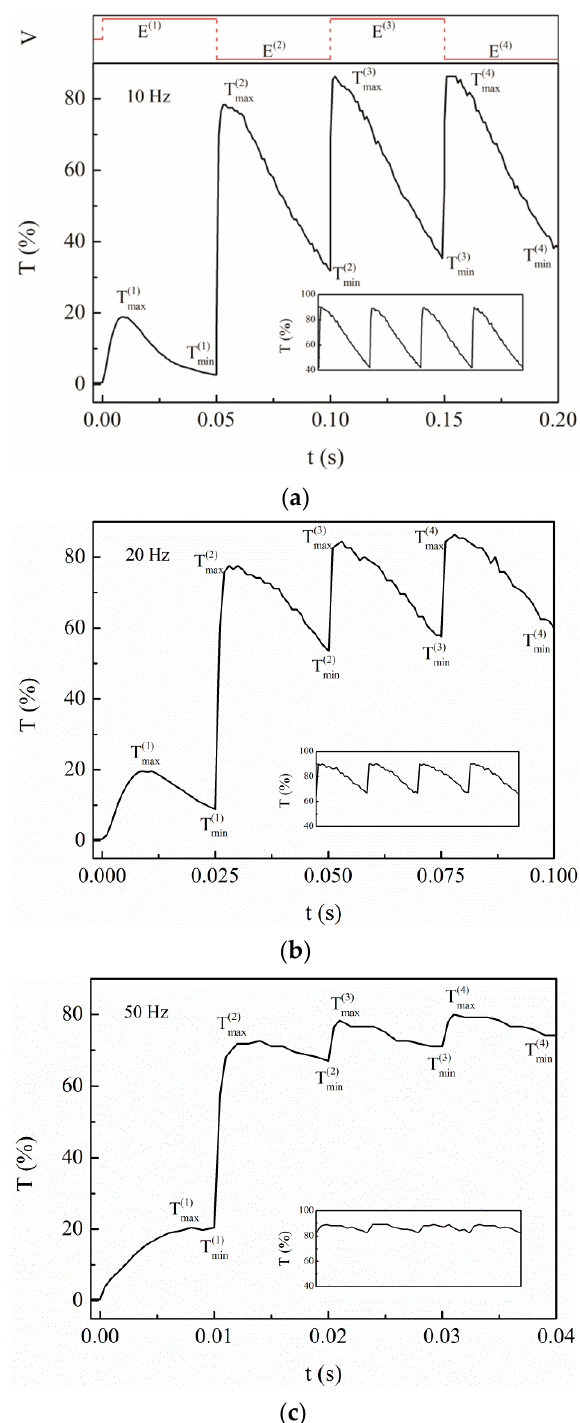
Figure 6. The T-t curves of the PDLC film by applying an AC square wave voltage at the frequencies of 10 Hz, 20 Hz, and 50 Hz, respectively. T and T correspond, respectively, to the minimum and maximum transmittances in the four T -periods: ( a ) 10 Hz, ( b ) 20 Hz, ( c ) 50 Hz. The resistance of the PDLC sample in this frequency range decreased with frequency ⁄ may decrease with 𝜌 (see Appendix A). Due to Equation (1), it can be assumed that 𝜌 p LC 𝑙𝑜𝑐(1) frequency so that 𝐸 and 𝑇 max(1) increase slightly with frequency. The T -periods were less than τ 10 , so that the curves T - t can only be characterized by the fast-response and the maximum internal depolarized electric field of the first T -period: